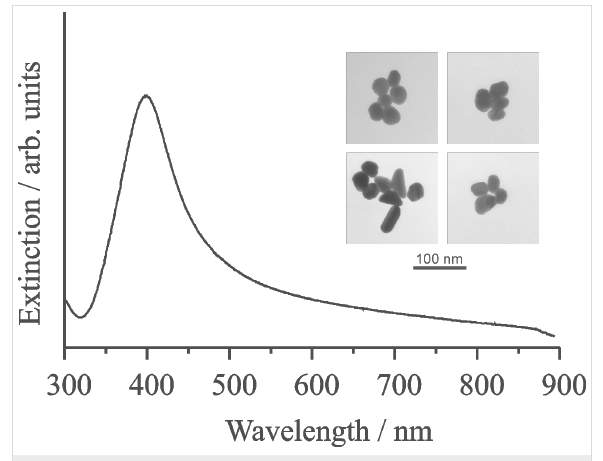
Figure 1: Electron micrographs of typical silver nanoaggregates that were used in this study and the extinction spectrum of their aqueous